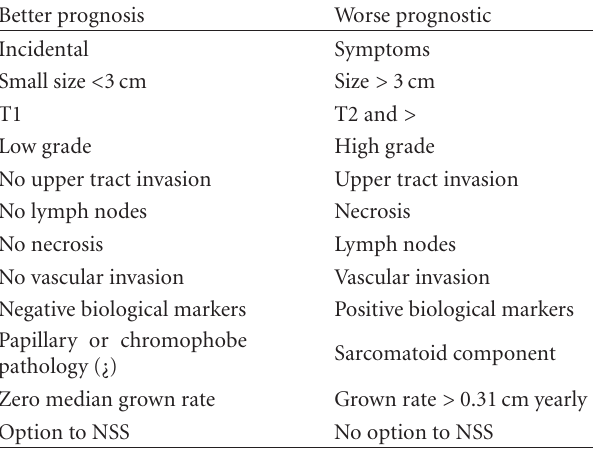
Table 1: Small RCC prognosis